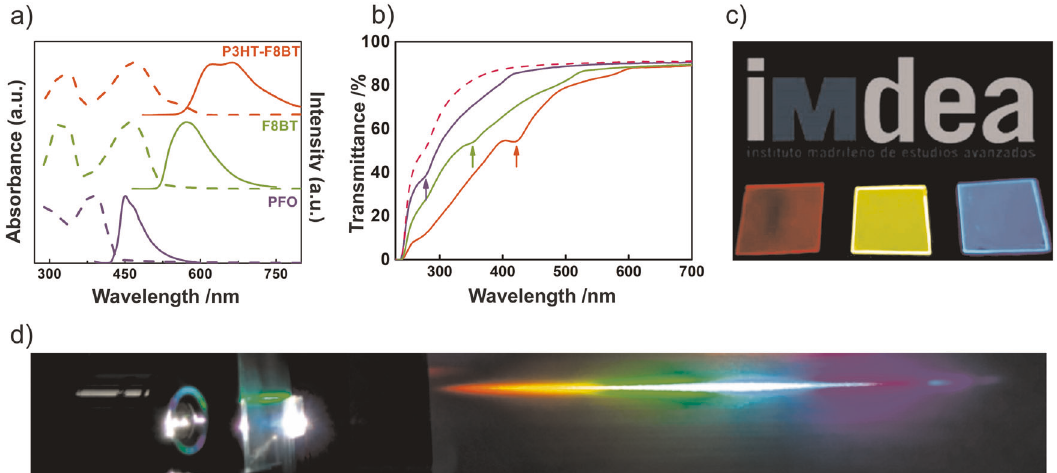
Fig. 1 a Normalized absorption and photoluminescence spectra of PFO (blue solid line and dot line), F8BT (green solid line and dot line), and P3HT:F8BT (red solid line and dot line). b Transmission spectra at normal incidence of LP (red solid line), MP (green solid line), and SP (blue solid line) gratings imprinted on CdA foils and of the unpatterned CdA substrate (pink dashed line). The arrows point at the transmittance dips, corresponding to the wavelengths of 278, 350, and 416 nm, respectively. c PFO (right), F8BT (middle), and P3HT:F8BT (left) DFB structures illuminated by a UV lamp. d Diffraction pattern of a naked CdA grating when exposed to white